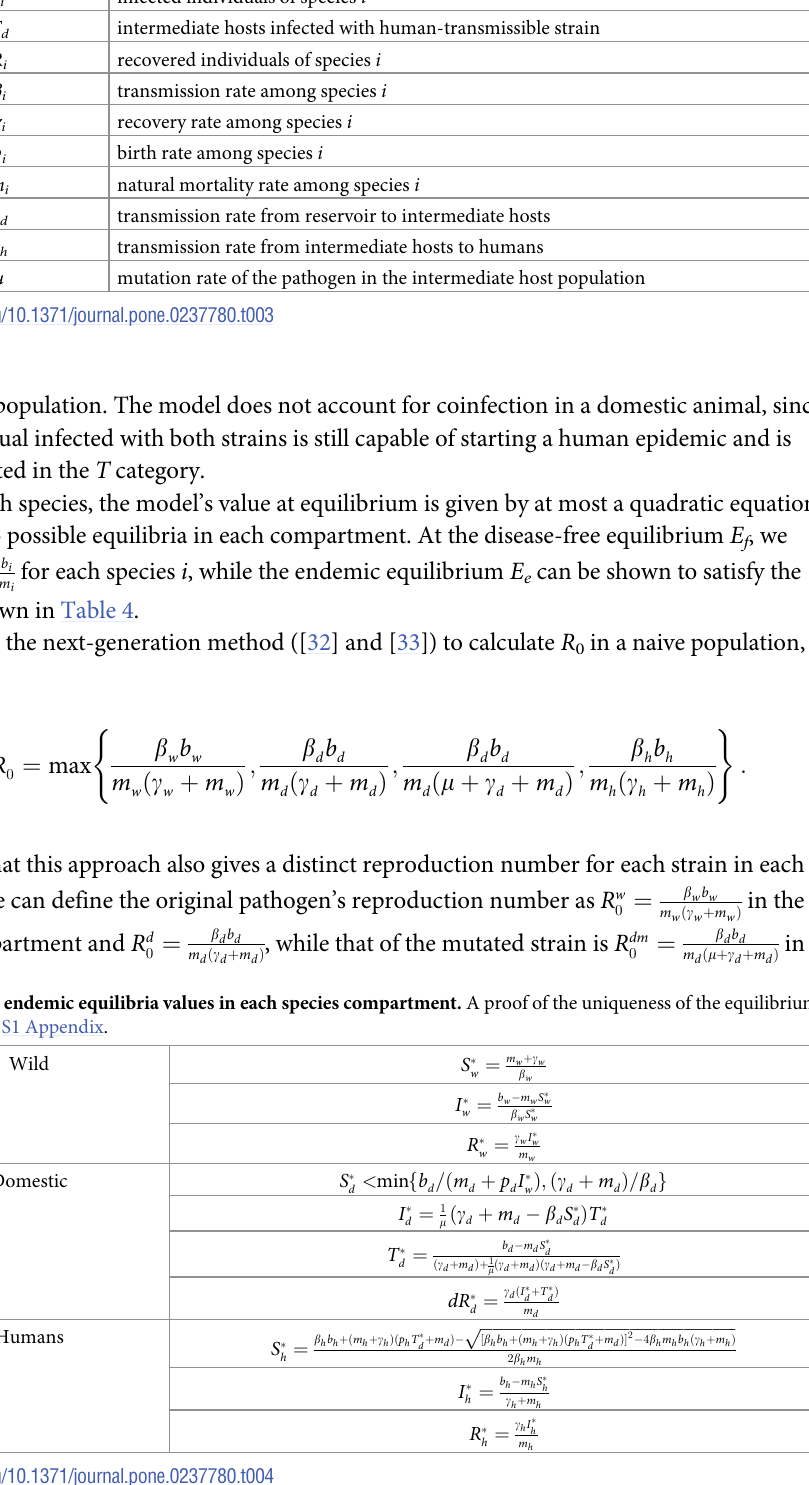
Table 3. Parameter definitions.